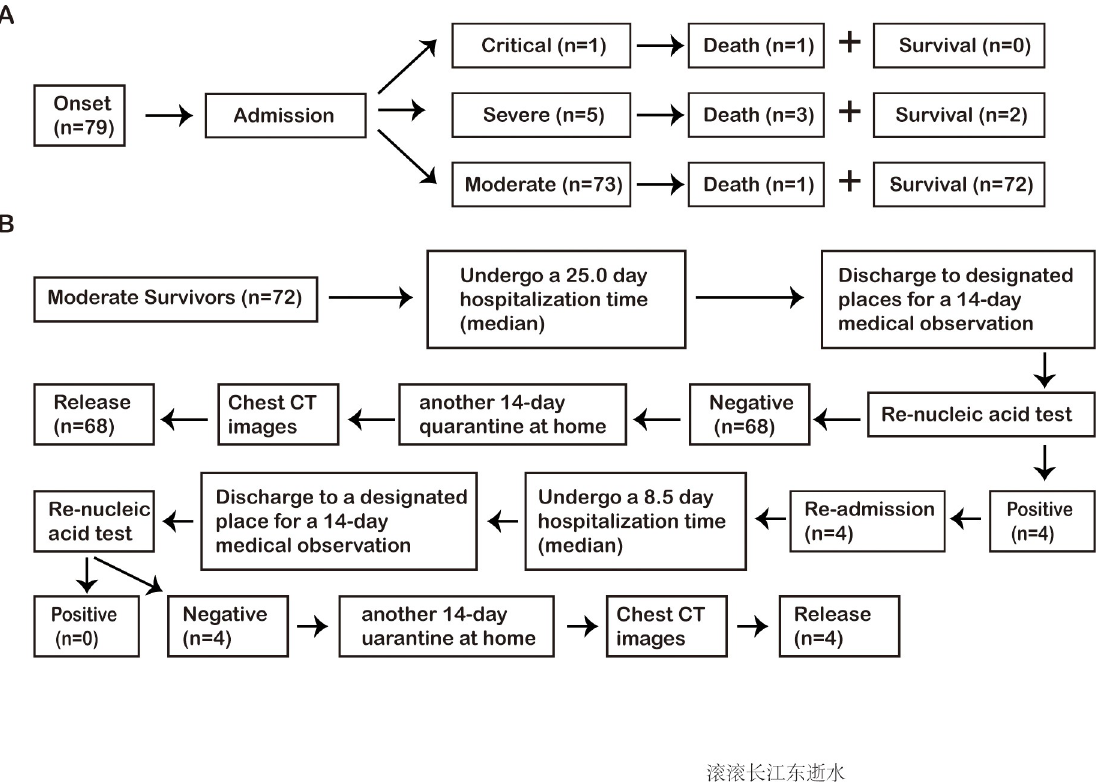
Fig 1. The prognosis of 79 patients with COVID-19 including 73 moderate cases, 5 severe cases, 1 critical case (A), and the flow chart of the clinical management for the 72 moderate survivors with COVID-19 (B). COVID-19, novel coronavirus